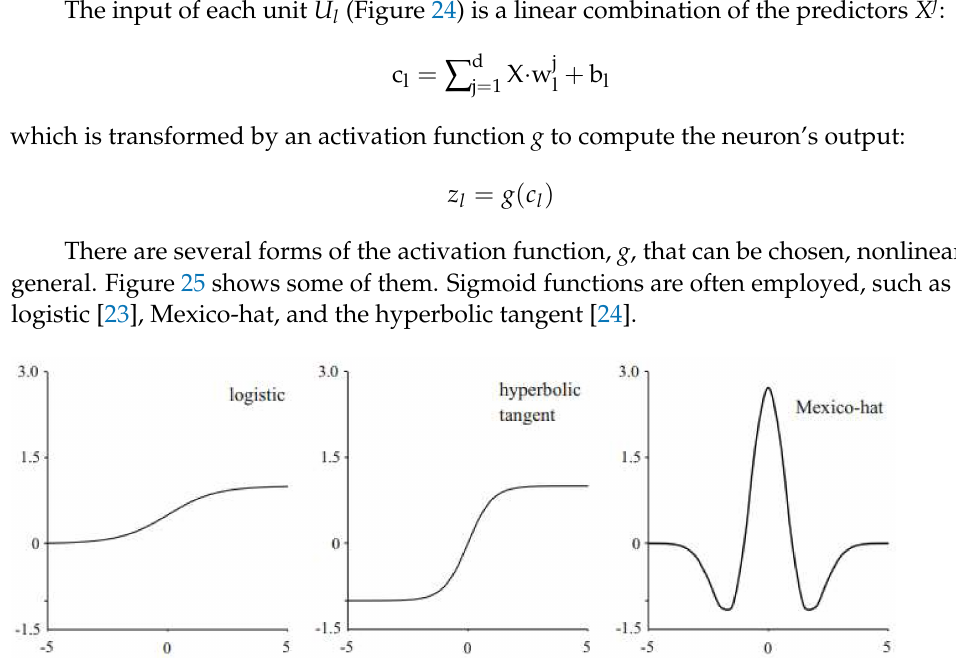
Figure 25. Common activation functions in Artificial Neural Networks